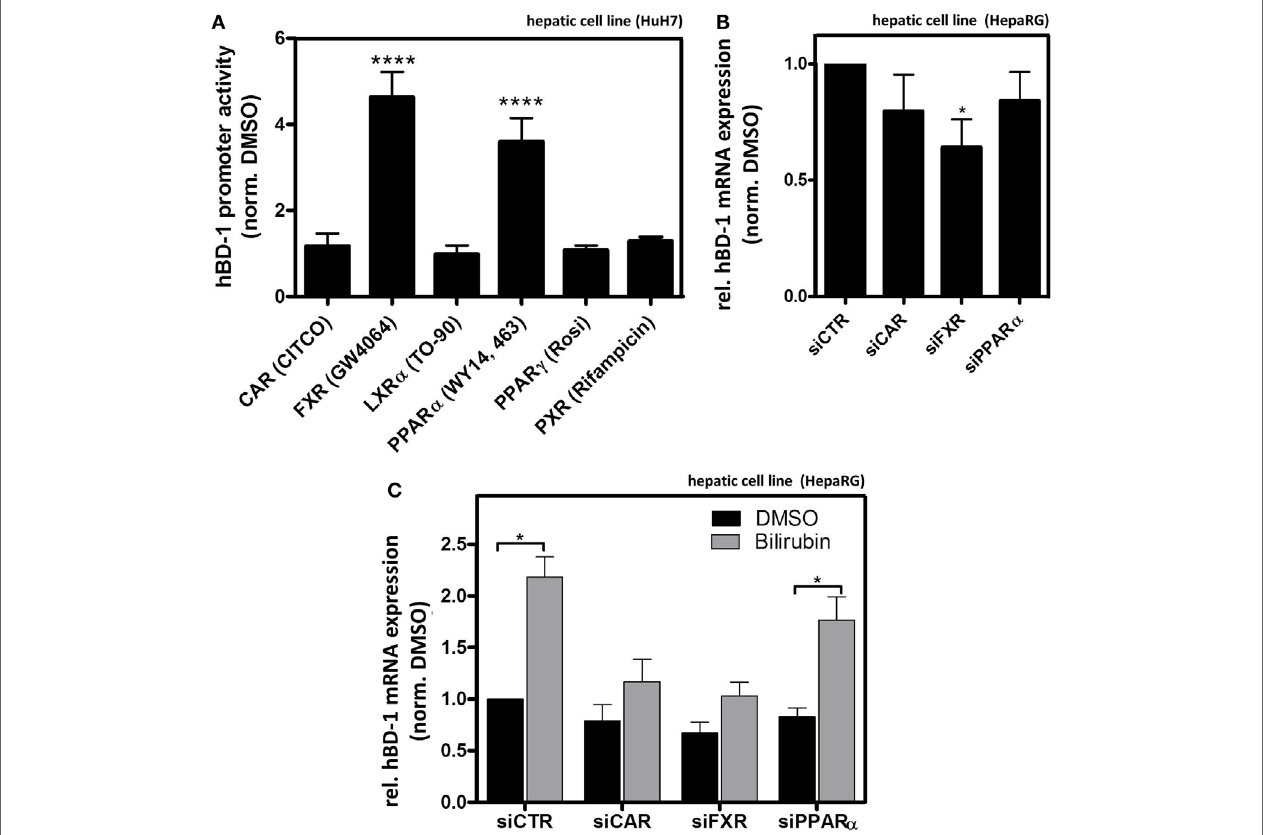
FigUre 6 | Farnesoid X receptor (FXR) and constitutive androstane receptor (CAR) modulate bilirubin-mediated hBD-1 induction. (a) Quantitative luciferase reporter gene assays with a construct containing 1,100 bp upstream region of hBD-1 promoter were performed in human HuH7 cells 48 h after indicated treatments with known agonists of nuclear receptors (ordered alphabetically) 5 µM CITCO (CAR), 10 µM GW4064 (FXR), 10 µM TO-90 (LXR α ), 100 µM WY14,643 (PPAR α ), 10 µM Rosiglitazone (PPAR γ , Rosi), and 10 µM of Rifampicin (PXR) in total 72 h after the transfection with the luciferase-containing constructs. The cells were co- transfected with the vector containing Renilla luciferase for normalization of transfection efficiency. The bars represent average fold change lucifearse induction normalized to solvent, DMSO, and control. Error bars indicate SD between three independent experiments. **** p < 0.001. (B) qRT-PCR assessment of hBD-1 mRNA expression in HepaRG lysates following transfections with the indicated small interfering RNAs (siRNAs), * p < 0.05. (c) qRT-PCR analysis of hBD-1 expression in HepaRG cells upon treatment with siRNAs targeting PPAR α (siPPAR α ), FXR (siFXR), CAR (siCAR), and non-targeting scramble siRNA (siCTR) (black bars) and in combination with bilirubin treatment for 48 h (grey bars). The bars represent average fold change expression normalized to hBD-1 expression in the cells treated with the solvent, DMSO, control, and siCTR. Error bars indicate SD between three independent experiments. * p < 0.05 compared to DMSO/siCTR control